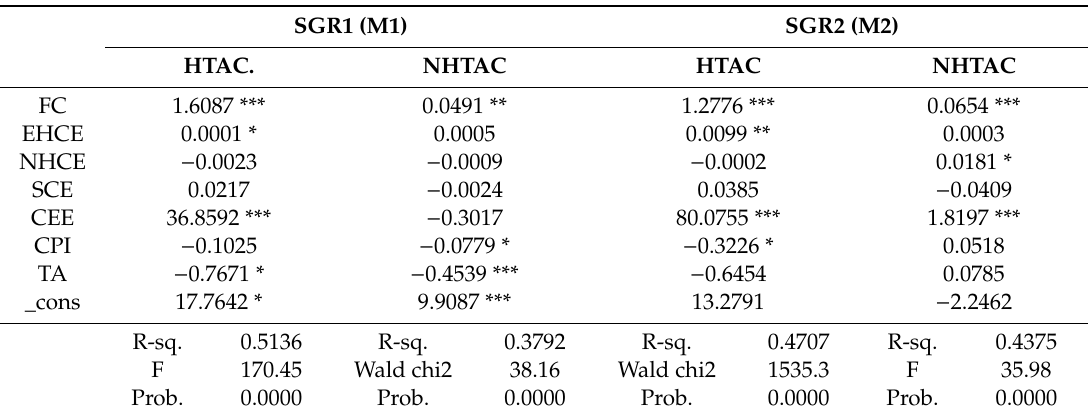
Table 8. Regression results of the